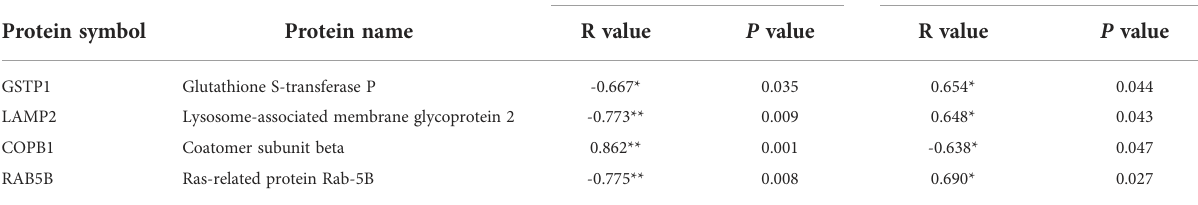
TABLE 2 Proteins differentially abundant in osteoporosis and iron accumulation. Associations with bone mass Associations with serum